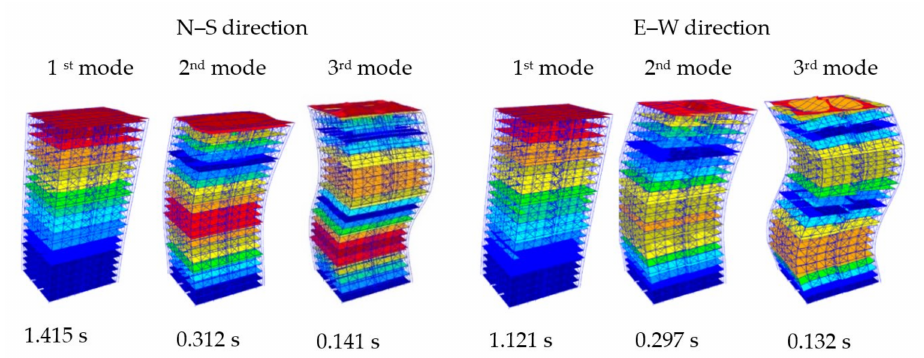
Figure 16. First mode shapes of the concrete concept with the modular substructures connected to the hyperfloors, the cores and the columns. Scale ratio of 5. Periods of the modes are under the